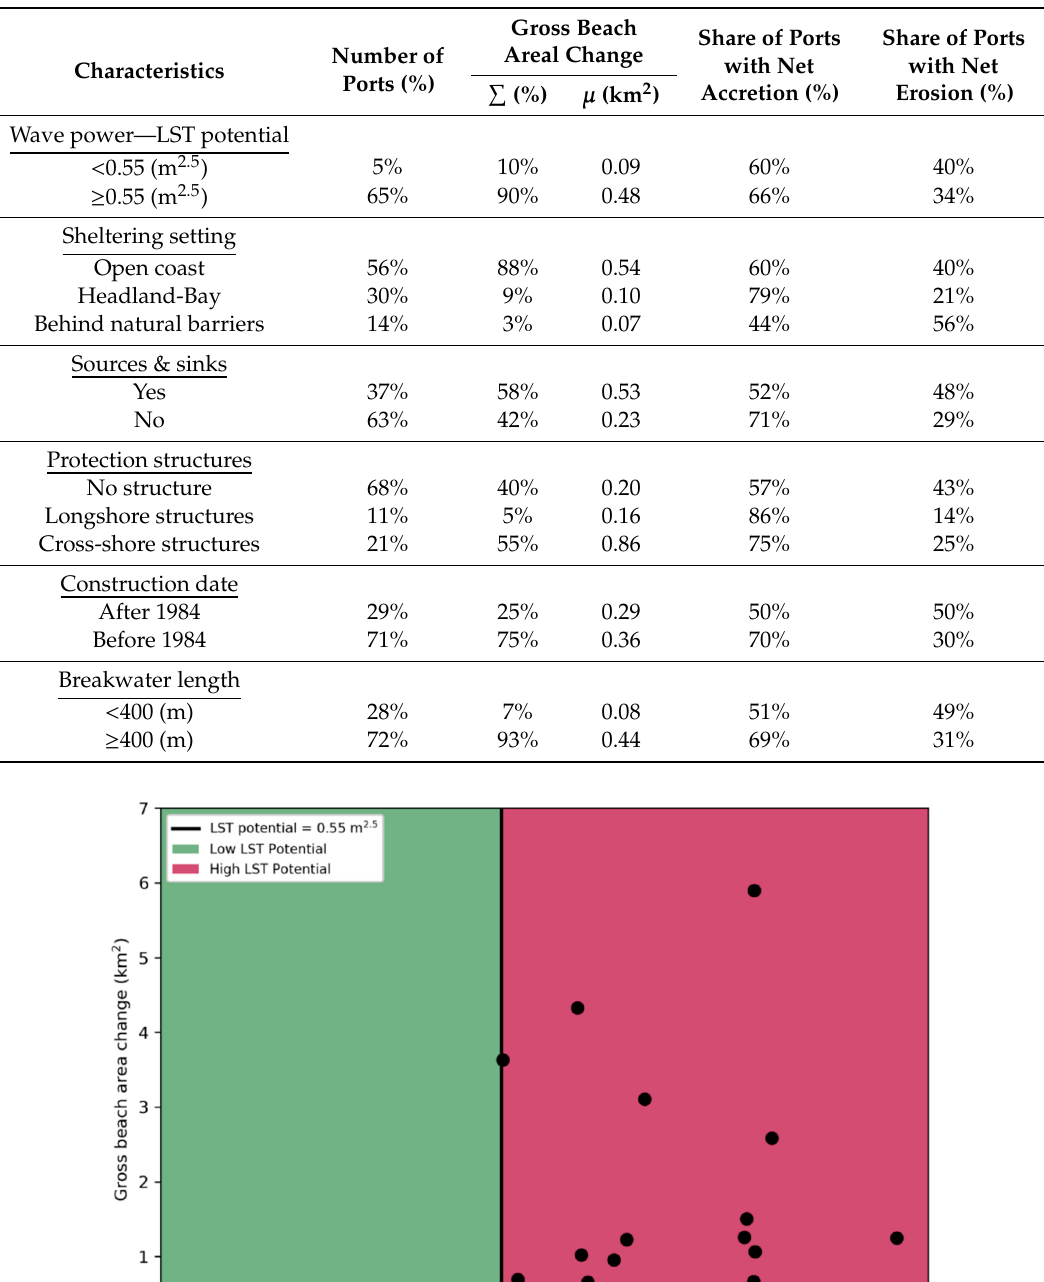
Table 4. Mapping of the 130 African seaports over the categories of each characteristic (in % of occurrence), their share in the gross beach areal change (%), the mean ( µ ) beach areal change (km 2 ), and the percentage of ports with net accretion and net erosion.